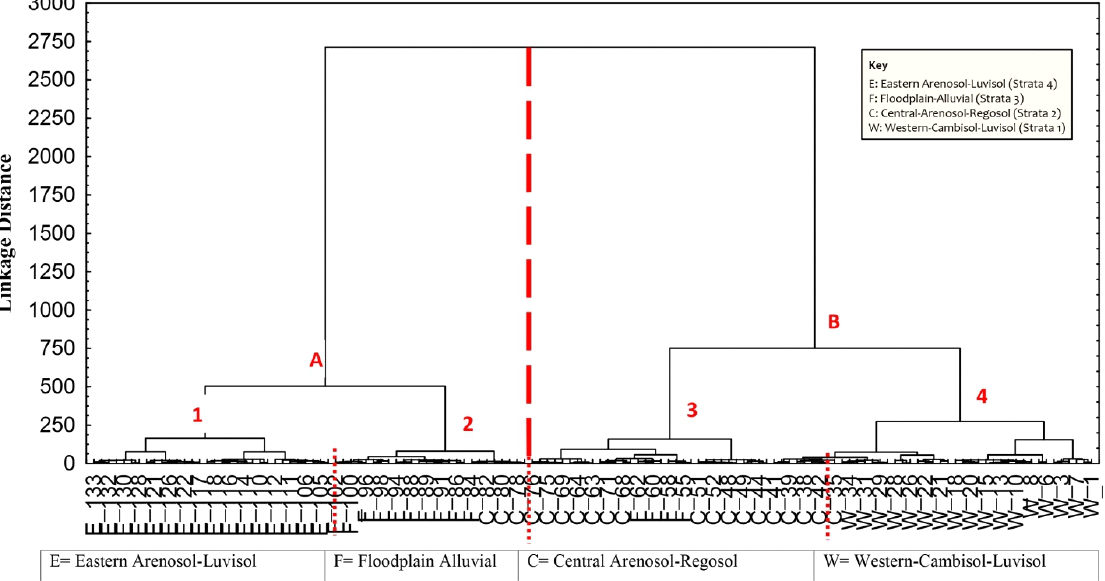
Fig. 4: Hierarchical Cluster Analysis dendrogram showing similarity of sample plots (Euclidean distance) across four soil substrates Notes: The sub-clusters are labeled 1-4 and the main clusters are labeled A and